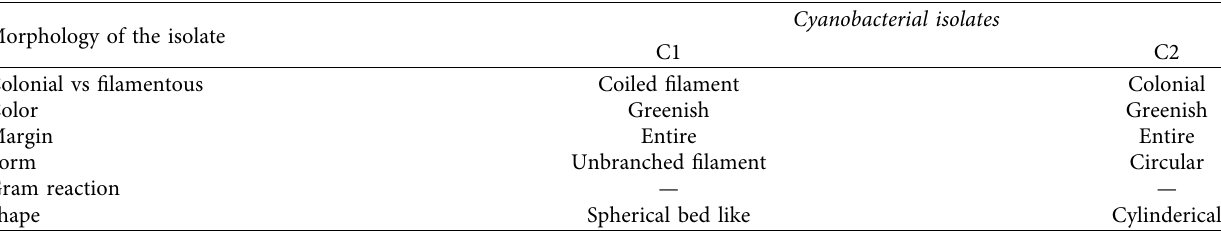
Table 3: Colony morphology of cyanobacteria isolates.